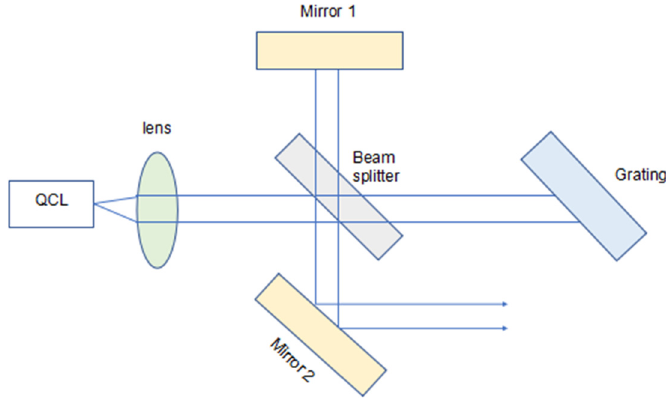
Figure 6. Intra-cavity out-coupling structure of ECQCL.